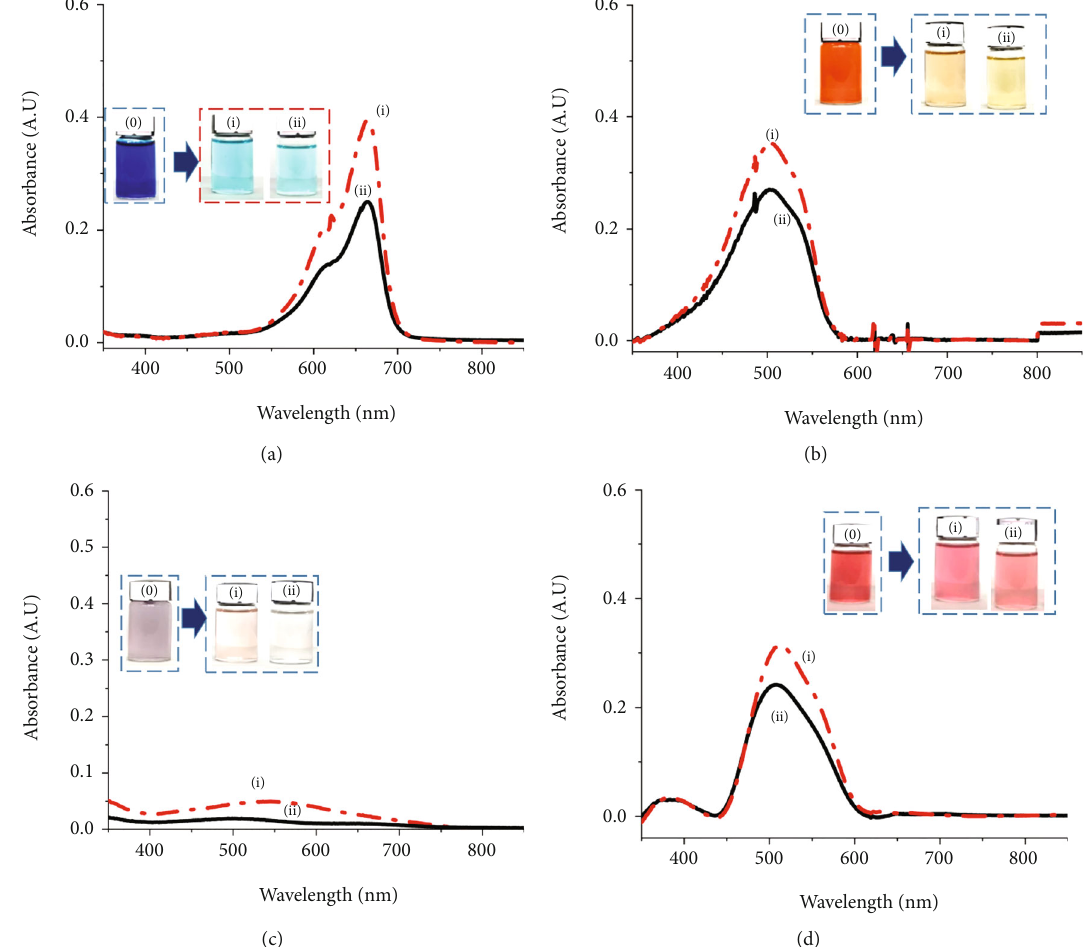
Figure 6: UV-Vis spectra of colorant solutions after adsorption of (a) MB, (b) MO, (c) CR, and (d) RS onto (i) GFC (red dot – dash) and (ii) GFC/NWPF (black solid) (inserted image: color of colorant solutions before and after